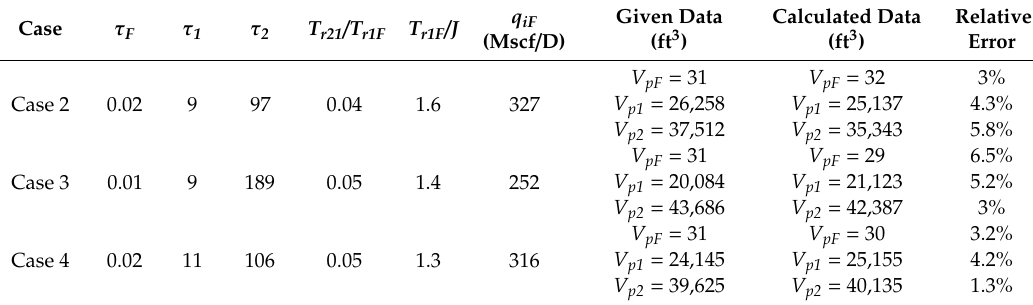
Table 4. Inferred parameter values according to fitting results.